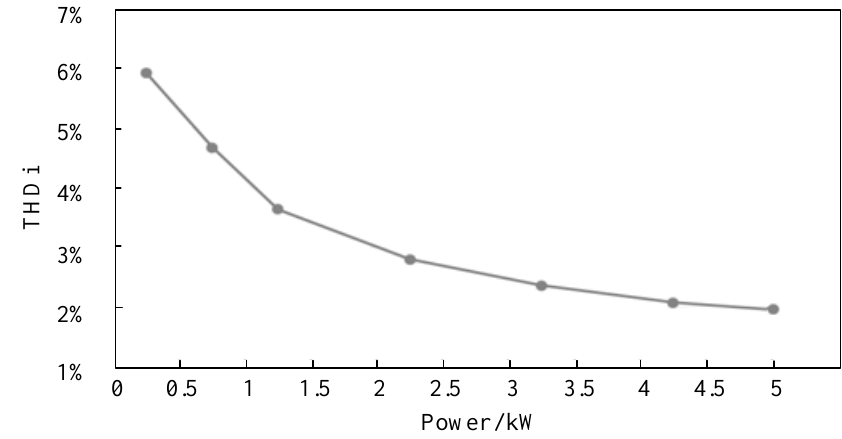
Figure 14. Efficiency of the PFC at different power levels.